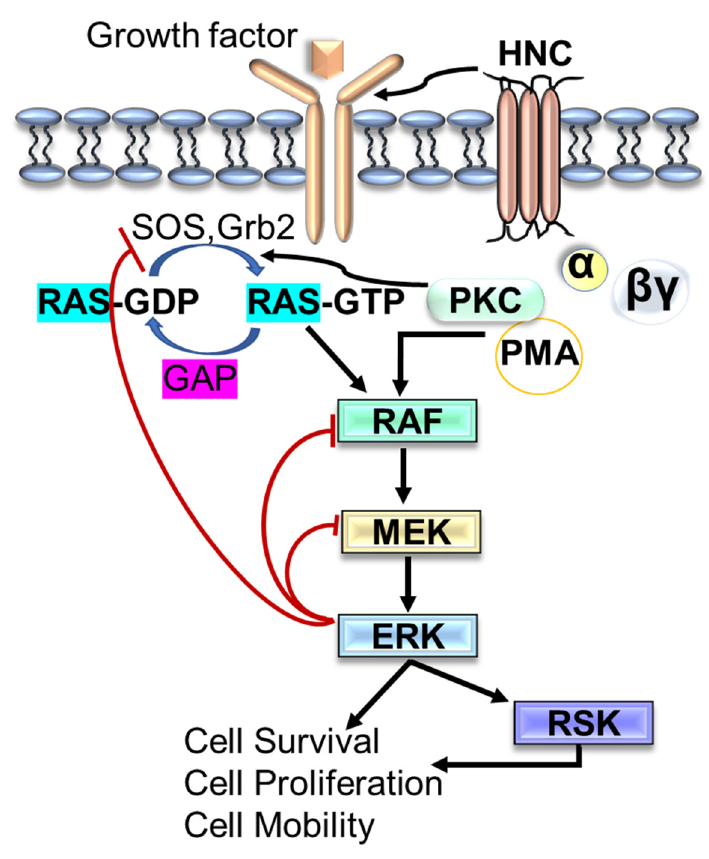
Figure 3. Schematic representation of Ras/MAPK pathway. ERK, Extracellular signal-regulated kinase; GAP, GTPase-activating protein; PKC; Protein kinase C; PM, Phorbol 12-myristate 13-acetate; RSK, Ribosomal s6 kinase.